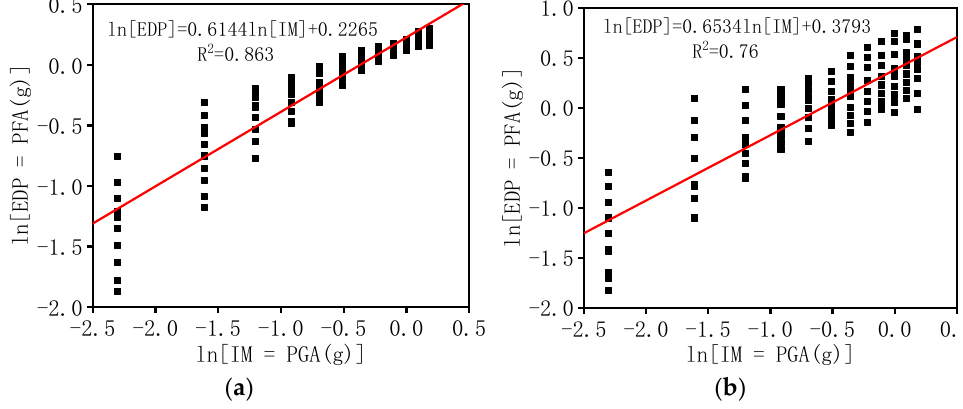
Figure 7. Relationship between ln[IM = PGA] and ln[EDP = PFA]: ( a ) CoSPSW, ( b ) SPSW. Table 13. Regression coefficients, standard deviation, and function for EDP–IM data